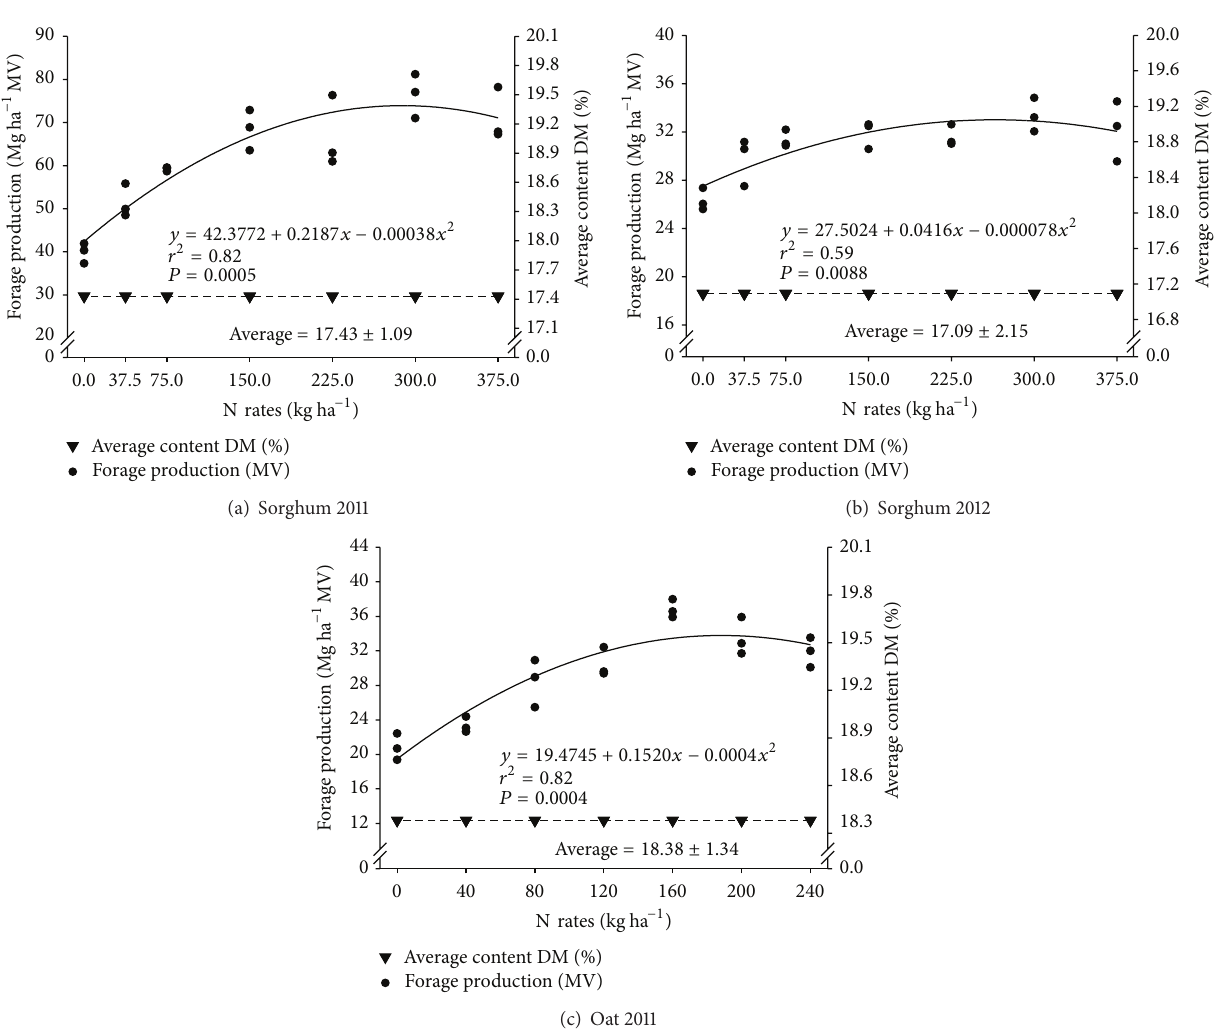
Figure 2: Cumulative production of forage (Mgha −1 ) and average content of dry matter (%) of sorghum in the summer seasons 2010/2011 (a) and 2011/2012 (b) and black oat in the winter of 2011 (c), under nitrogen